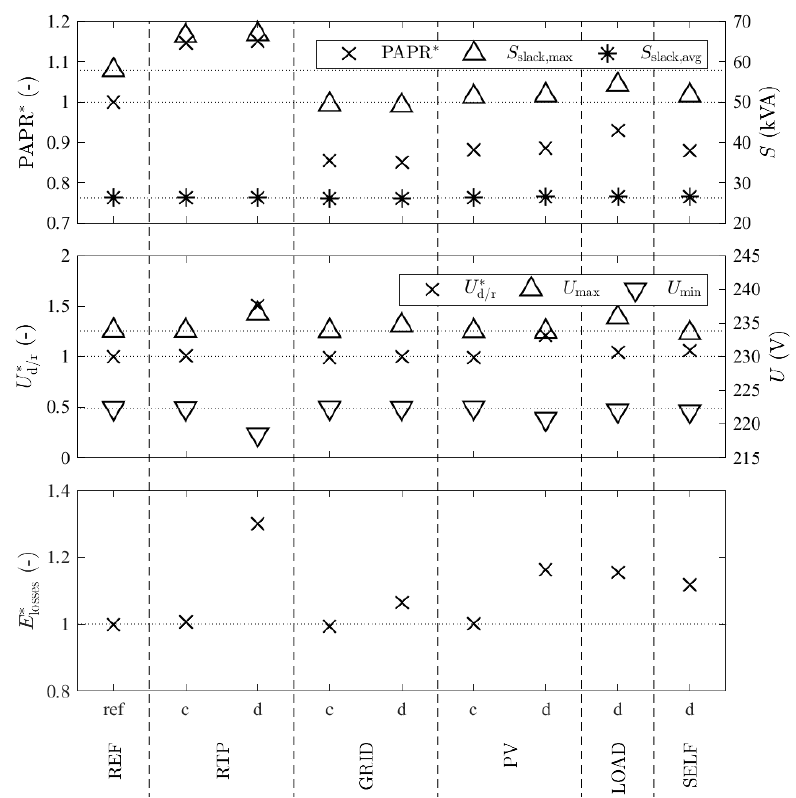
Figure 3. Peak-to-average power ratio, voltages and cumulative distribution losses for all configurations for a single, central storage (c) and multiple, distributed storages (d). The superscript * refers to normed = E losses quantities with respect to the reference case, i.e., E ∗ , analogously for U d/r and PAPR. E losses, REF losses